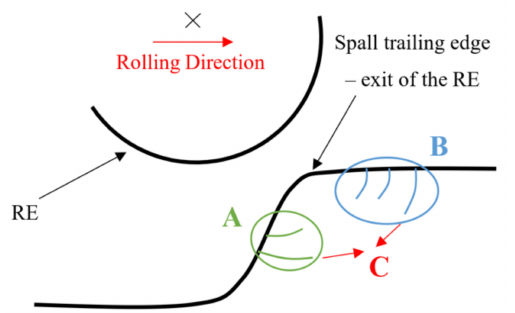
Figure 19. Schematic description of the propagation stages of a spall. “A” is a propagation stage where sub-surface cracks appear underneath the spall trailing edge. In Stage “B”, cracks appear in front of the trailing edge of the spall, and in Stage “C”, the cracks propagate and coalesce until a fragment is released from the